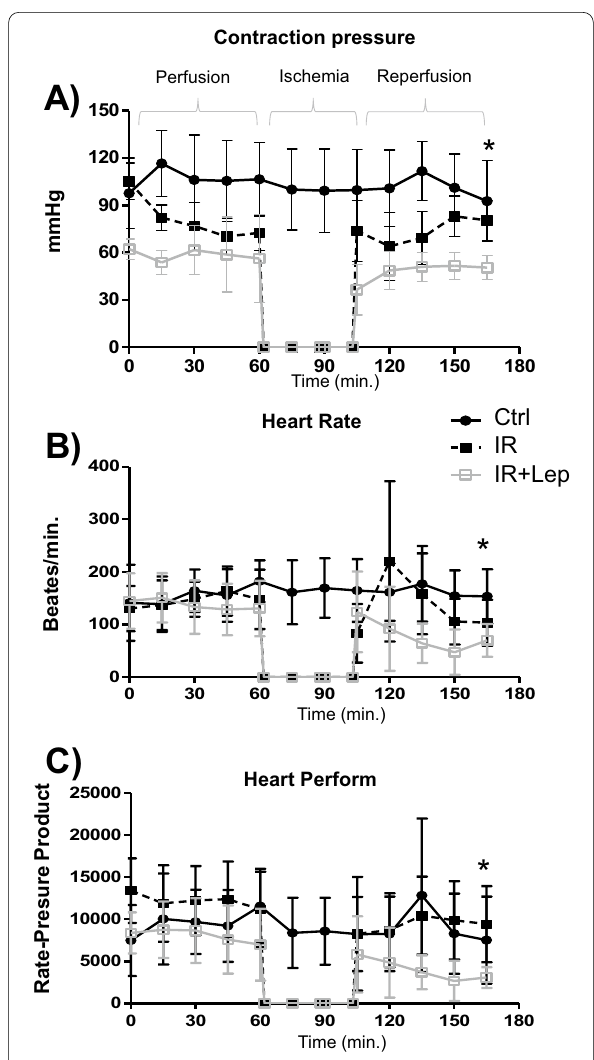
Fig. 2 Effect of leptin on cardiac rate‑pressure product (heart performance). A Plot of heart contraction pressure of leptin‑perfused and control hearts (mmHg). B Plot of heart rate (bpm) of leptin‑perfused and control hearts. C Heart rate‑pressure product of leptin‑perfused and control hearts; ( n 3). Ctrl control without = ischemia; IR ischemia–reperfusion; Lep leptin. * p < 0.05 of AUC